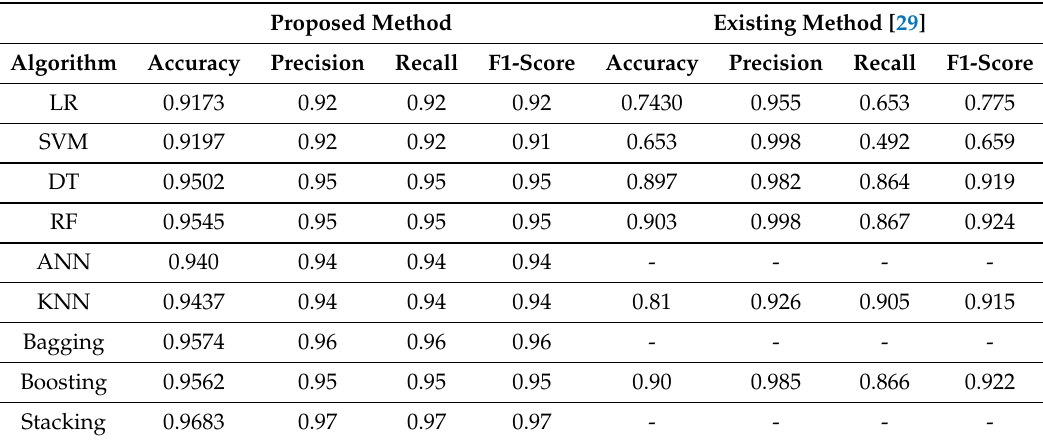
Table 9. Comparison of binary classification performance on